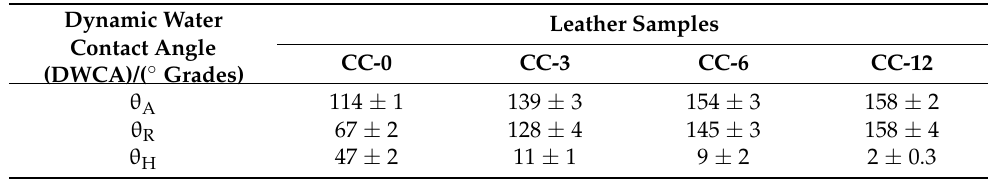
Table 5. Values of advance, receding and hysteresis contact angles of uncoated and plasma-coated leather samples.